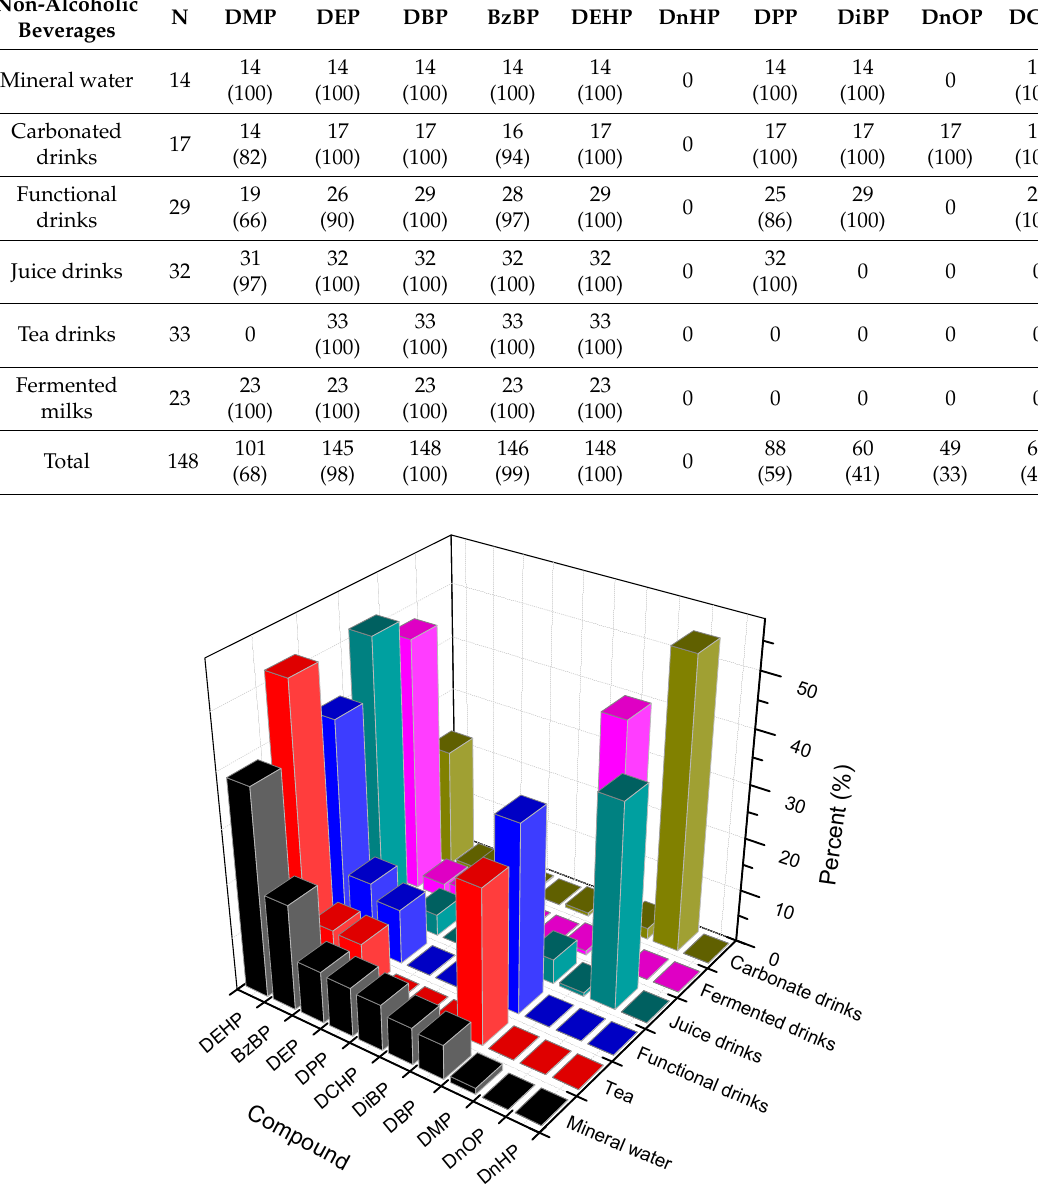
Table 8. Phthalate concentrations in different types of non-alcoholic beverages (µg/L).